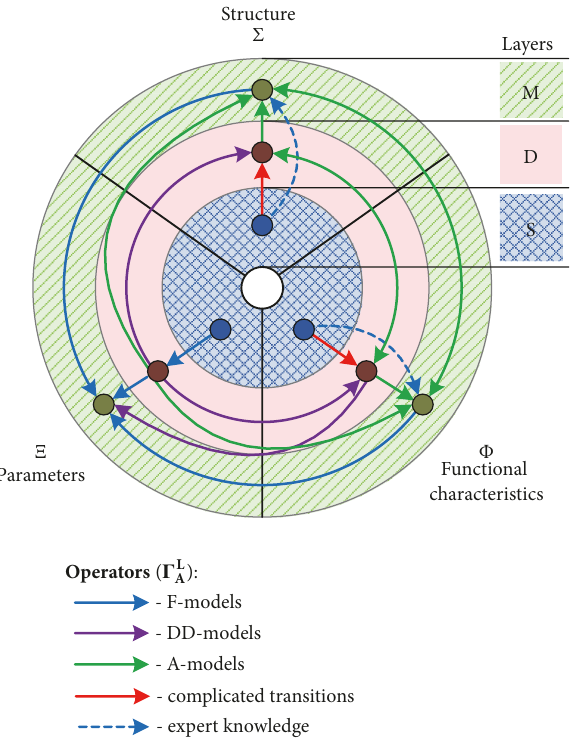
Figure 1: Basic concepts of complex modeling on model ( 𝑀 ), data ( 𝐷 ), and system ( 𝑆 )